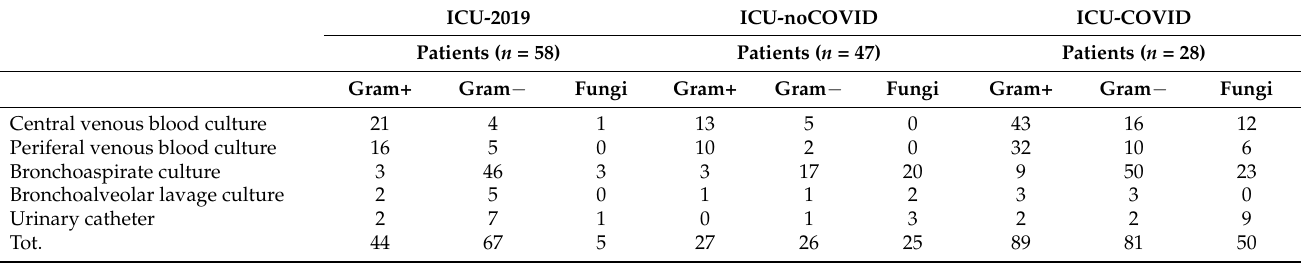
Table 2. Gram-positive and Gram-negative bacteria and fungal